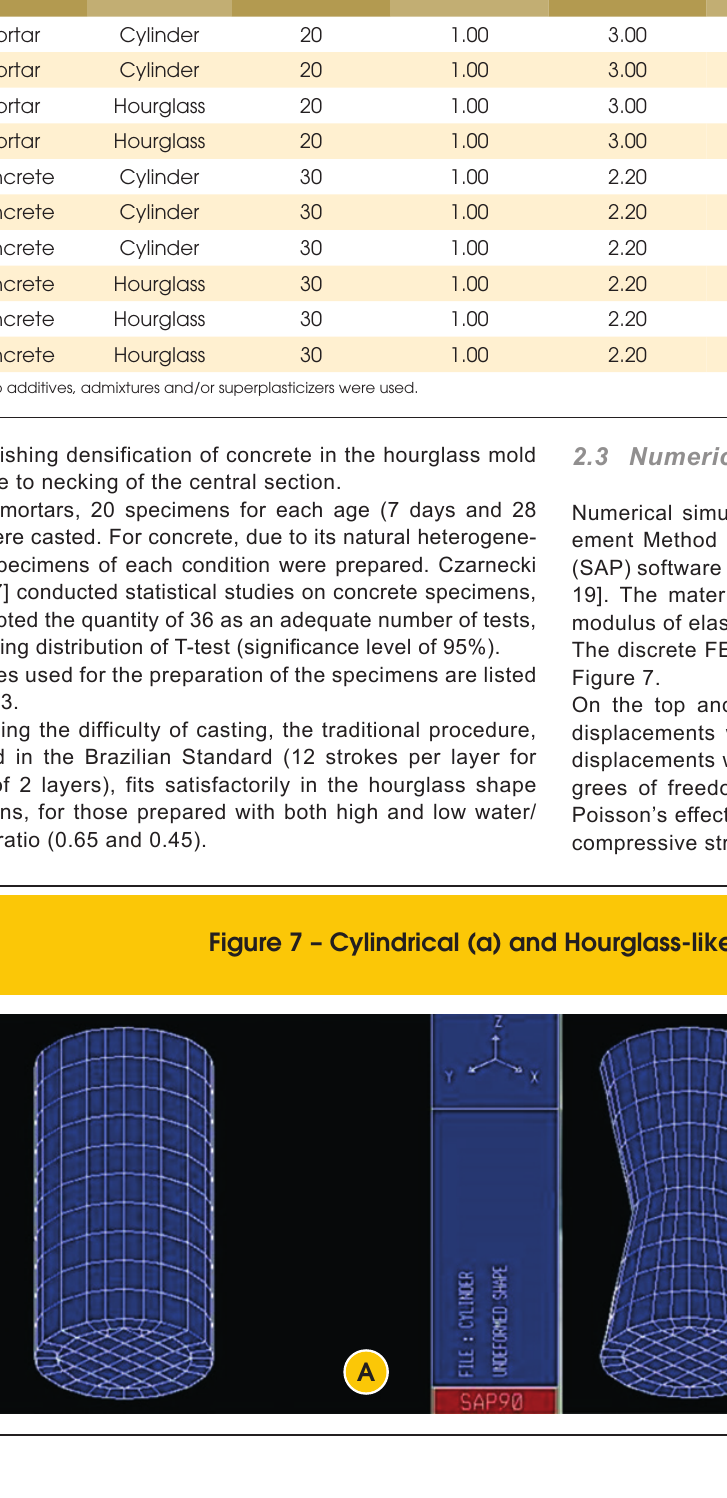
Table 3 – Geometries – mix proportion of tested samples Material Mort./Concr.